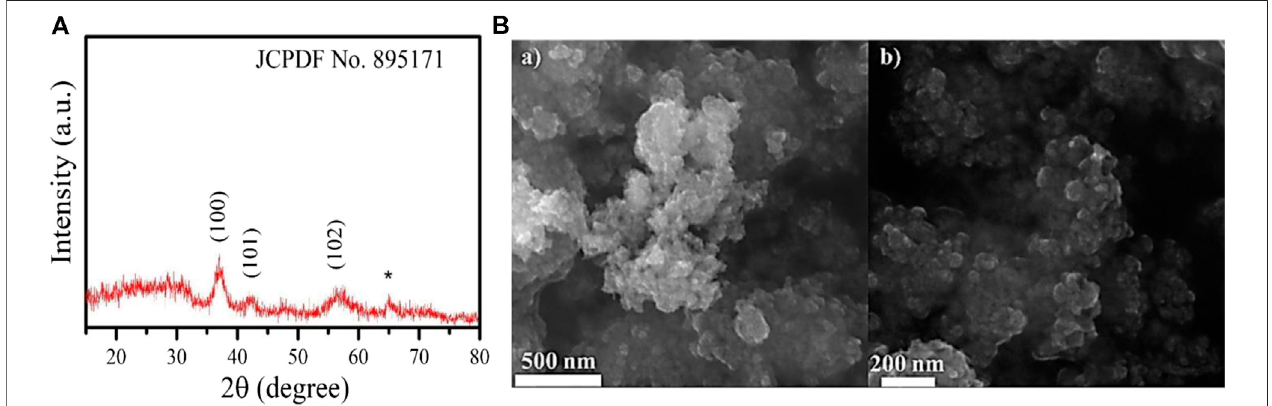
FIGURE 1 | (A) XRD pattern of MnO 2 nps calcined at 350 ° C; (B) Scanning electron microscopic image of MnO 2 nps recorded (a) lower magni fi cation and (b) at higher magni fi cation showing spherically shaped MnO 2 nps calcined at 350 °